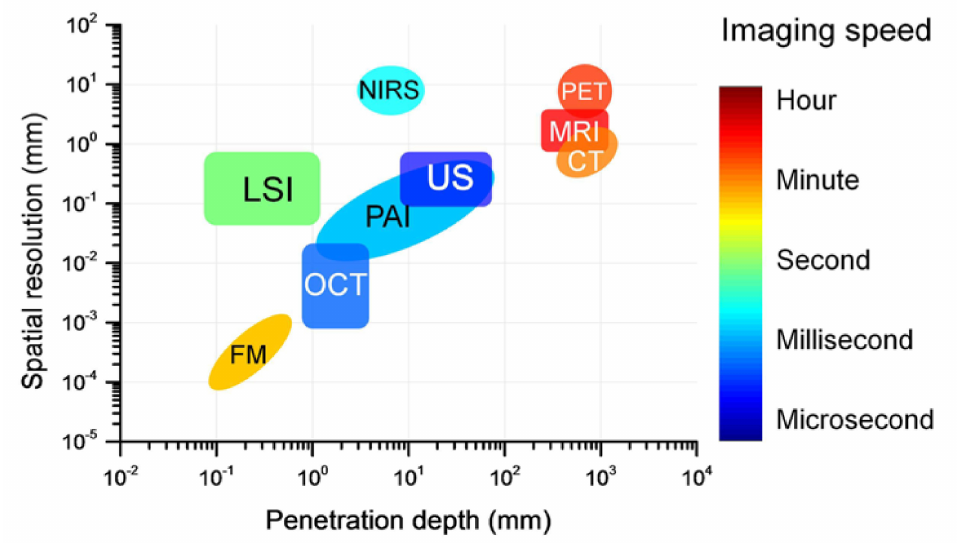
Figure 3. Comparisons of the penetration depth, spatial resolution and image speed among various techniques for neuroimaging, including magnetic resonance imaging (MRI), computed tomography (CT), positron emission tomography (PET), ultrasound imaging (US), optical coherence tomography (OCT), photoacoustic imaging (PAI), fluorescence microscopy (FM), near-infrared spectral imaging (NIRS), and laser speckle imaging (LSI). Reprinted with permission from ref.